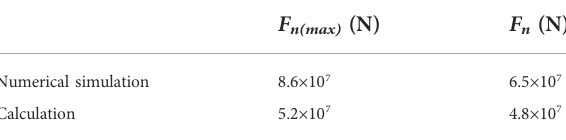
TABLE 4 Comparison of impact forces based on numerical simulation and